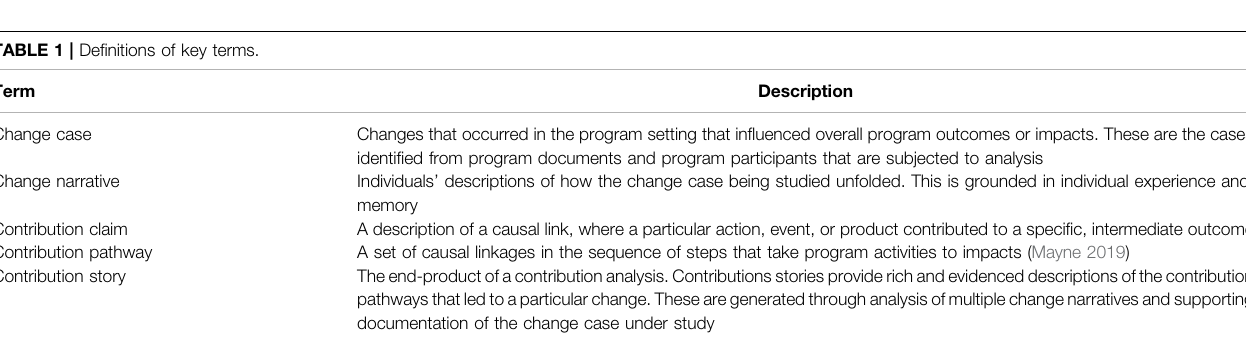
TABLE 1 | De fi nitions of key